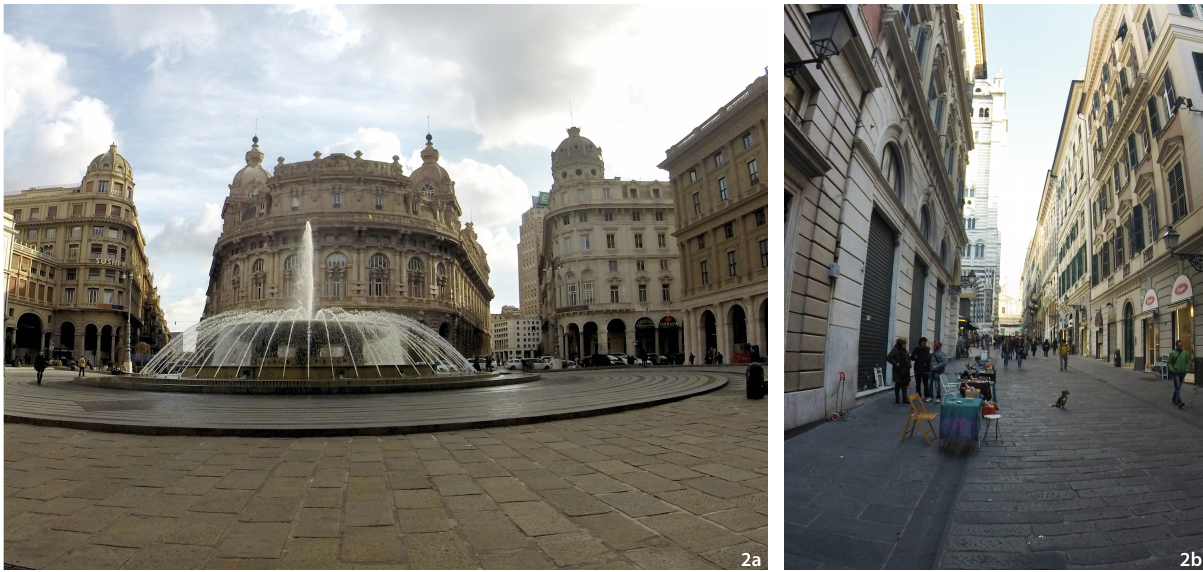
Figure 2a Newly restored and pedestrianised public spaces, Piazza Ferrari (Source: the author). Figure 2b Newly restored and pedestrianised public spaces, Via San Lorenzo (Source: the